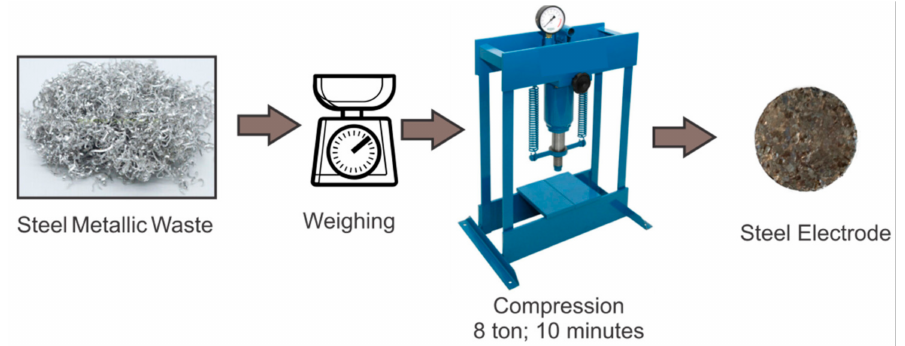
Figure 1. Schematic preparation of steel-swarf-based (SfE)